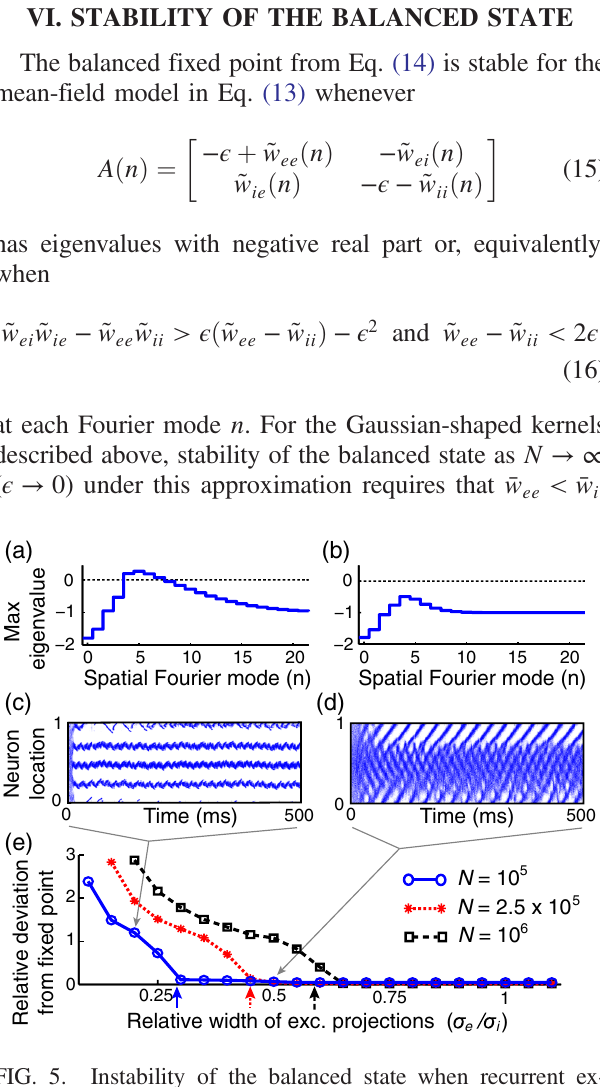
FIG. 5. Instability of the balanced state when recurrent ex- citation is too narrow compared to inhibition. (a),(b) Maximum real part of eigenvalues of the matrix A ð n Þ from Eq. (15) as a 0 . 02 in (a) and σ 0 . 05 in (b) (other function of n with σ e ¼ e ¼ parameters as in Fig. 2). (c),(d) Spike rasters from simulations of 0 . 1 , the LIF network. (e) Relative L 2 deviation of simulated firing o ¼ rates from the fixed point determined by Eq. (12) for various values of σ and N (see inset). Vertical arrows along the e = σ horizontal axis mark the smallest value of σ at which some e i eigenvalue of A ð n Þ has positive real